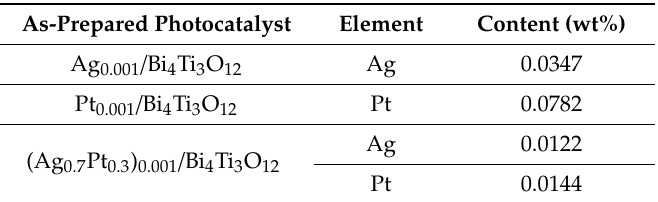
Table 3. The content of Ag and Pt in the as-prepared photocatalysts.